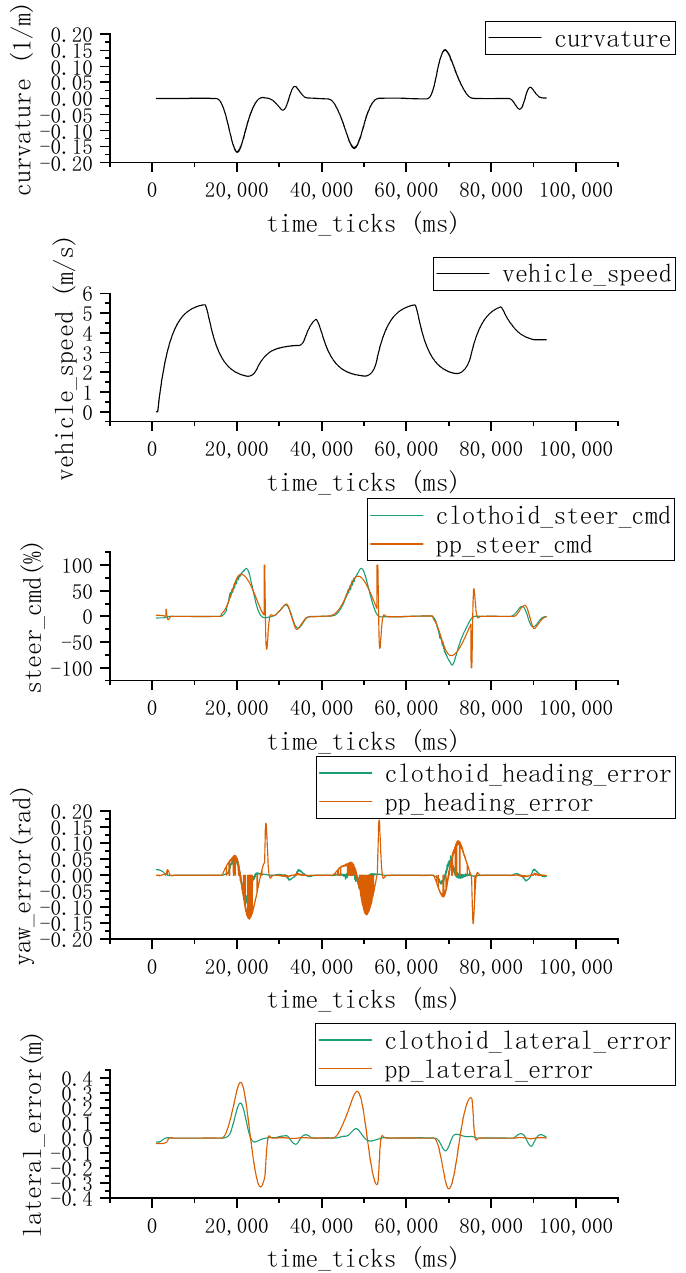
Figure 10. Speed limit 20 km/h trajectory tracking. Top first row: the curvatures along the field test road. Second row: actual speed of the vehicle during the trajectory tracking experiment under the speed limit of 20 km/h. It can be seen that the vehicle will slow down according to the curvature of the road ahead before entering the curve. Third row: steering wheel angle commands the comparison between the pure pursuit method and the method proposed in this paper. It can be seen that the steering wheel angle control commands given by the pure pursuit method still suffer a drastic oscillation when leaving the right-angle turn. Fourth row: yaw angle deviation from the reference path point. The obvious direction deviation generated by the pure pursuit tracking method when leaving the right-angle turn also appears as expected. Last row: lateral deviation from the reference path. The performance of the method proposed in this paper is obviously better than the pure pursuit tracking method when passing through right-angle curves, but the accuracy is slightly lower when passing through S curves with a small